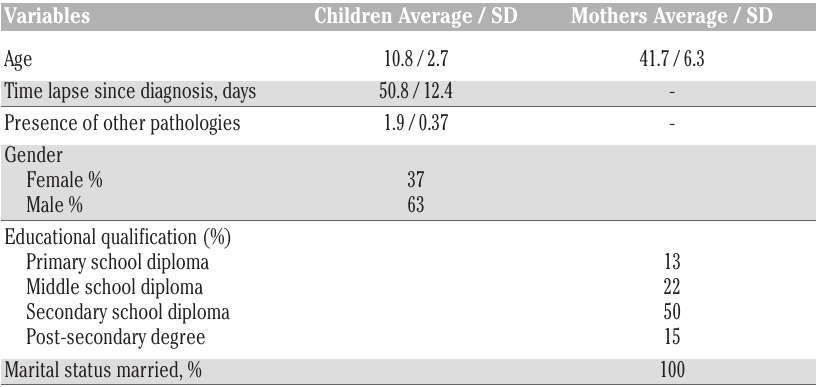
Table 1. Characteristics of the two study groups (children N= 60; mothers N=